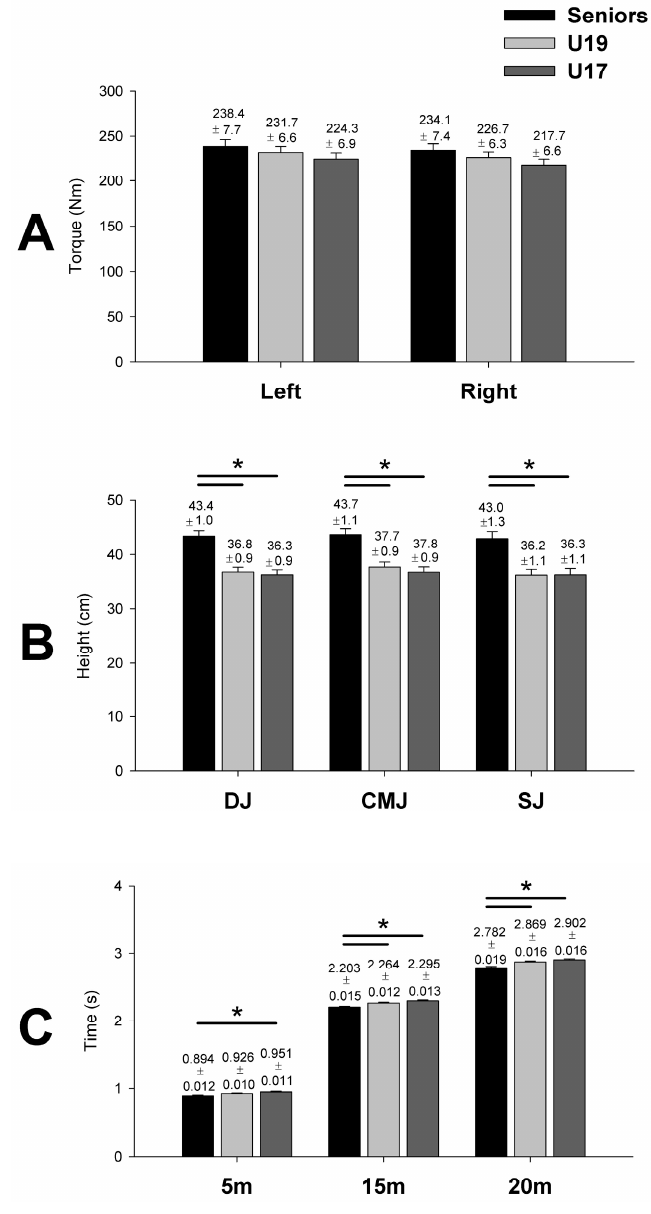
Figure 1. Estimated marginal means ± standard deviations of ( A ) knee extension peak torque of both lower limbs; ( B ) vertical jump height in three jump tests, and ( C ) sprint times at 5, 15, and 20 m for the different age groups. * p < 0.05. Legend: DJ; drop jump; SJ; squat jump; CMJ; countermovement jump.